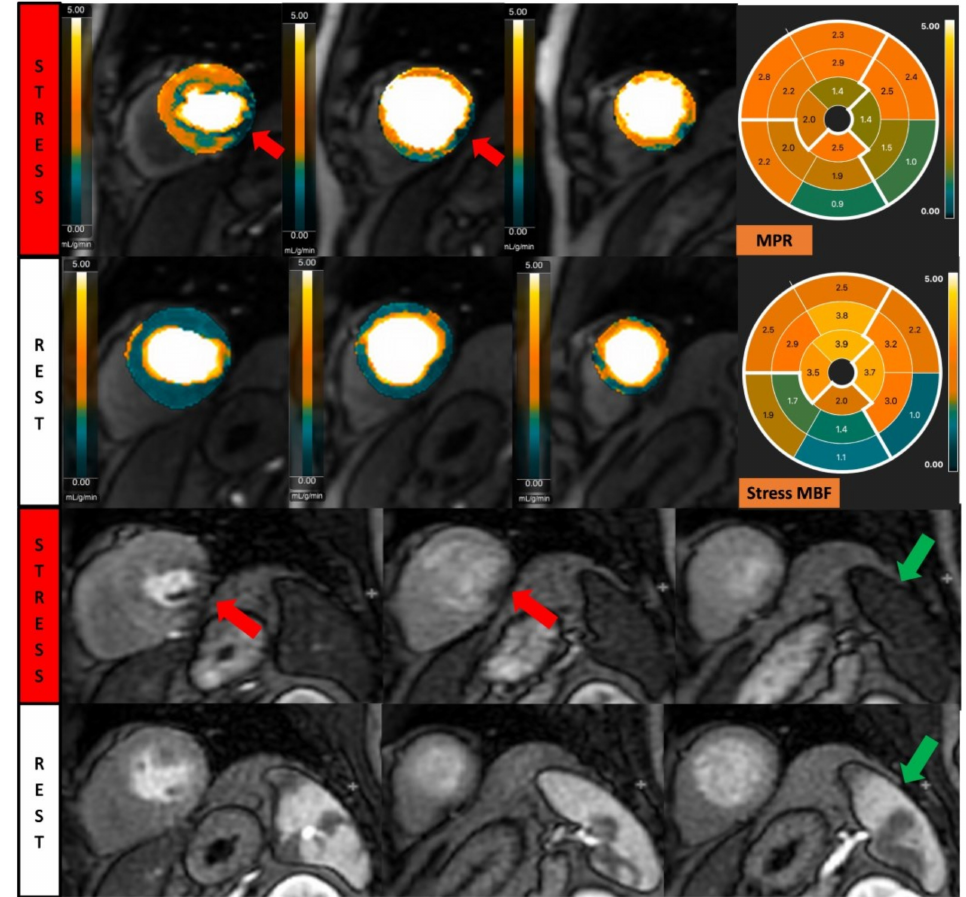
Figure 2. Fully quantitative analysis of myocardial blood flow (MBF) of significant CAD. Male, 55 years old, presenting with chest pain during hiking. CCTA showed chronic total occlusion